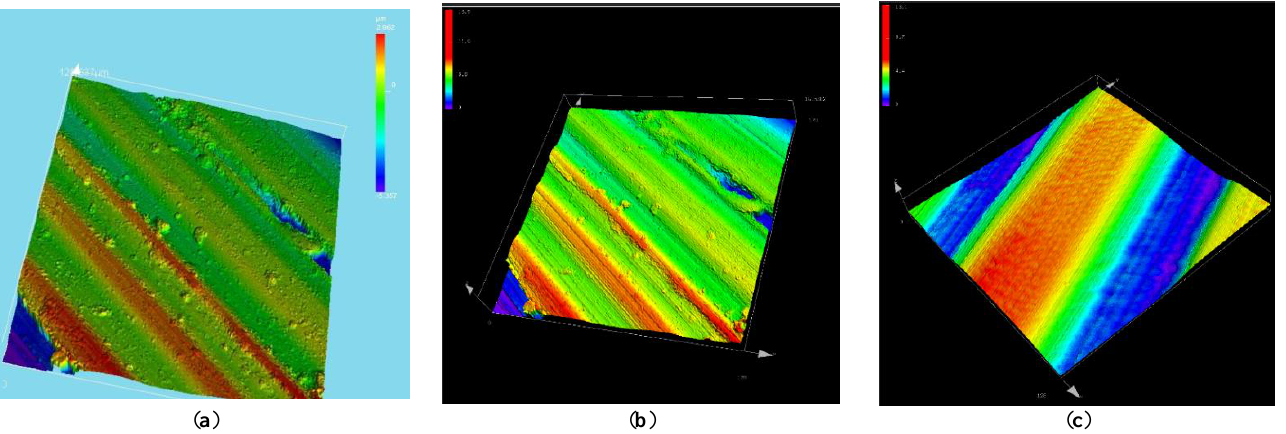
Figure 9. 3D profile image of the worn surface of UHMWPE discs: ( a ) against SN0 pin; ( b ) against SN20 pin; ( c ) against SN30.